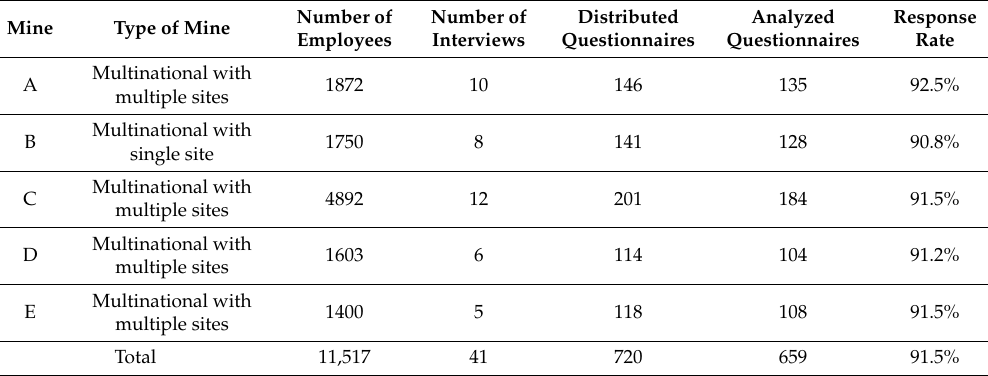
Table 1. Distribution of responses across the five participating